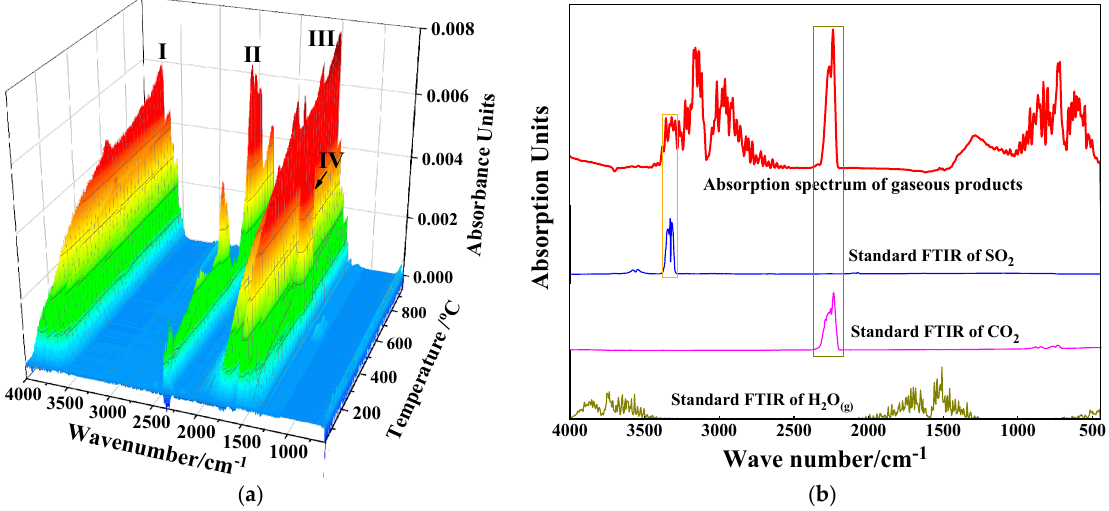
Figure 4. ( a ) Three-dimensional and ( b ) two-dimensional FTIR spectra of the gaseous products.